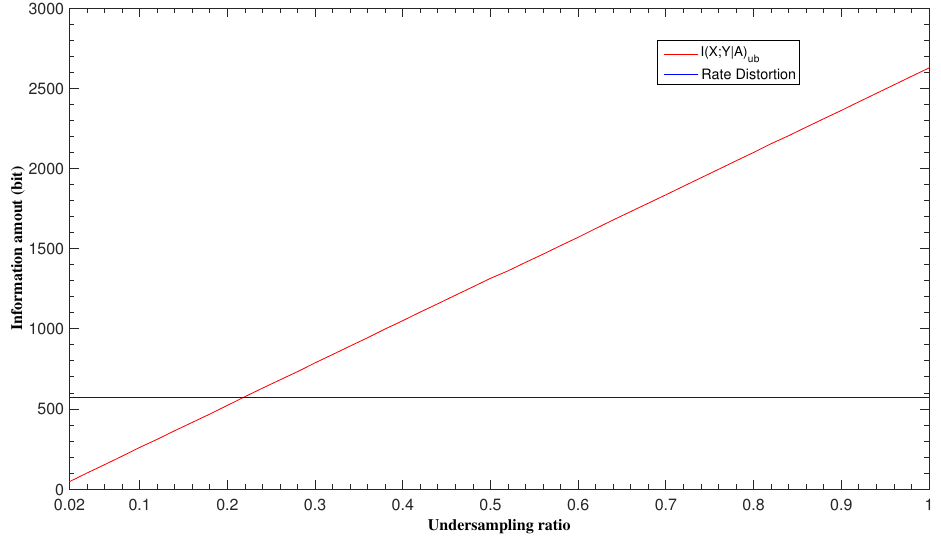
Figure 1. Rate distortion and upper bound for mutual information under different undersampling ratio, with sparsity, SNR and distortion fixed as 0.2, 10 dB, 0.01,